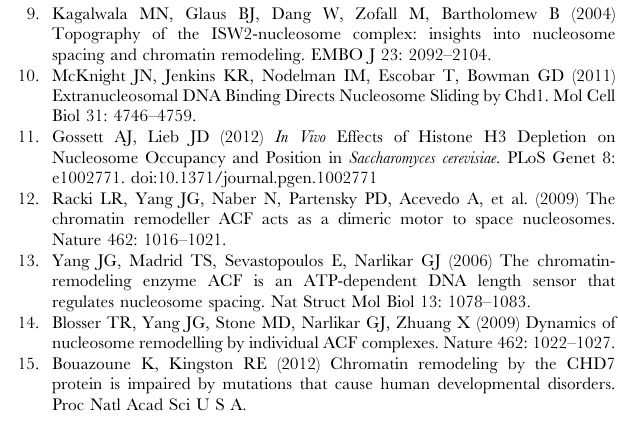
(TIF) Figure S3 V-plots of wild-type and catalytically inactive Isw1, binding sites. Binding sites are derived from the data of Rhee and Pugh [45]. (TIF) Figure S4 Loss of remodeler catalytic activity does not alter remodeler fragment size distributions. Size distributions of mapped paired-end 2.5 9 MNase-digested wild-type and K215R Isw2 and wild-type and K407R Chd1 ChIP and input fragments. (TIF) Figure S5 V-plots of catalytically inactive Isw1, Isw2 and Chd1 ChIP and input data at Abf1, Cbf1, Mbp1, and Reb1 sites. (TIF) Figure S6 Isw1 association with 5 9 NDRs is captured by X- ChIP-seq. Heatmaps of log 2 (Isw1 IP/input) native and crosslinked 2.5 9 MNase signal 6 1 kb of verified ORF 5 9 ends ranked descending by gene expression level. (TIF) Table S1 Yeast strains used in this study. All strains are derived from W1588-4C, which is isogenic to W303-1A except that a weak RAD5 mutation is repaired [74]. Table S2 Numbers of mapped pairs and supernucleosomal/ nucleosomal AUC ratios for sequenced samples. ChIP/input is the ChIP supernucleosomal/nucleosomal AUC ratio divided by the input supernucleosomal/nucleosomal AUC